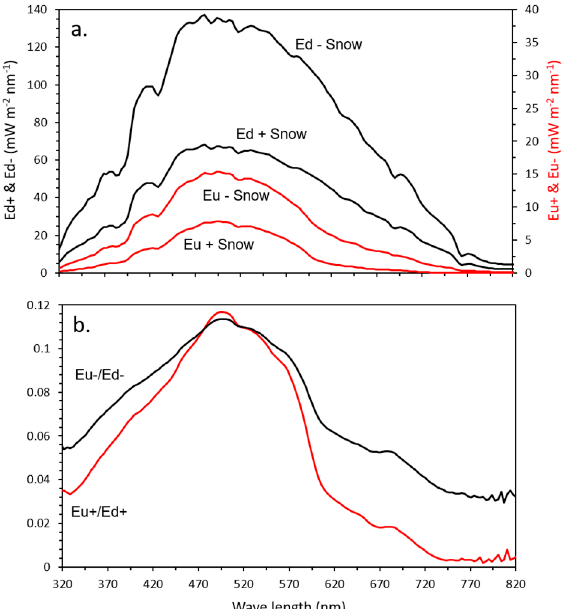
Figure 5. Spectral distribution of downwelling irradiance 3 cm below the ice bottom without snow cover (Ed − Snow), with a snow cover (Ed + Snow), upwelling without snow cover (Eu − Snow), and upwelling with a snow cover (Eu + Snow) ( a ) and spectral distribution of the ratio between upwelling and downwelling irradiance without snow cover (Eu − /Ed − ) and with a snow cover (Eu +/Ed +) ( b ).